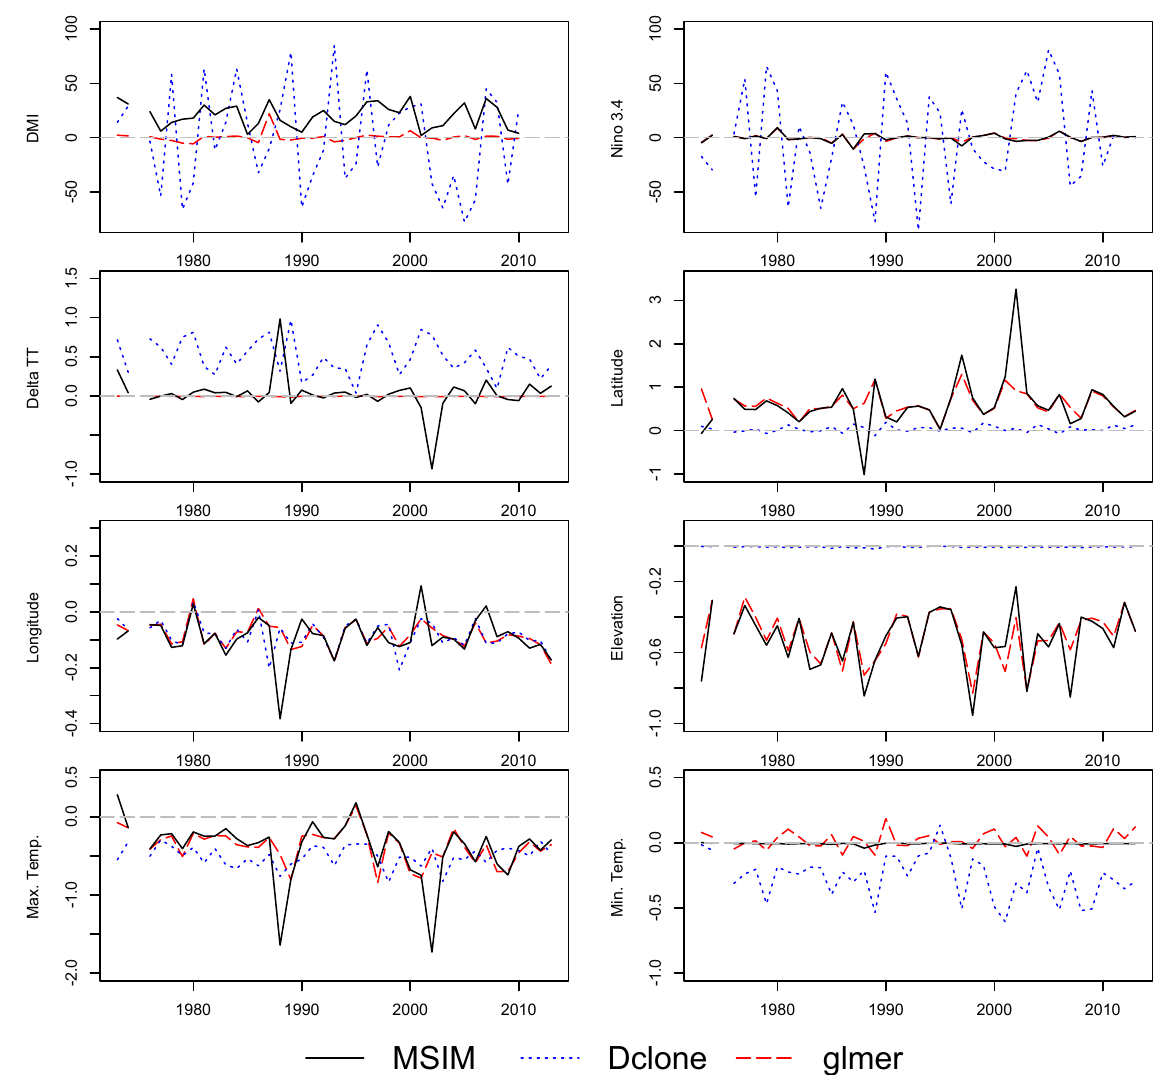
Figure 5. Fixed coefficient estimates for logit-normal models with extreme Indian rainfall ( ≥ 124.4mmday − 1 ) response from